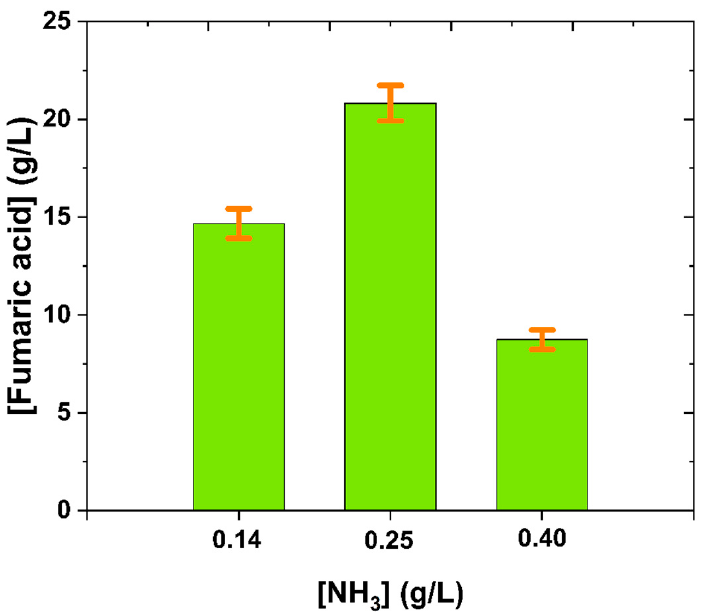
Figure 5. Nitrogen source concentration selection for complementing APH.